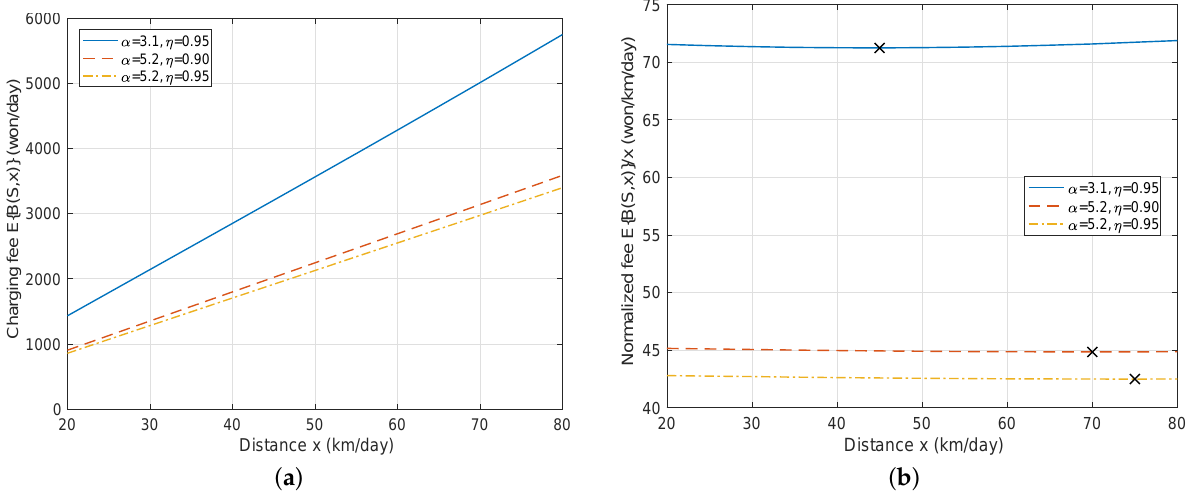
Figure 6. Charging fee example for Plan 1 of Figure 3 and the distribution f S of Figure 5, when the supplied power is ¯ ρ = 3 kW (KRW 1000 is USD 0.83). ( a ) Conditional mean charging fee E { B ( S , x ) } of (8). ( b ) Normalized conditional charging fee E { B ( S , x ) } / x